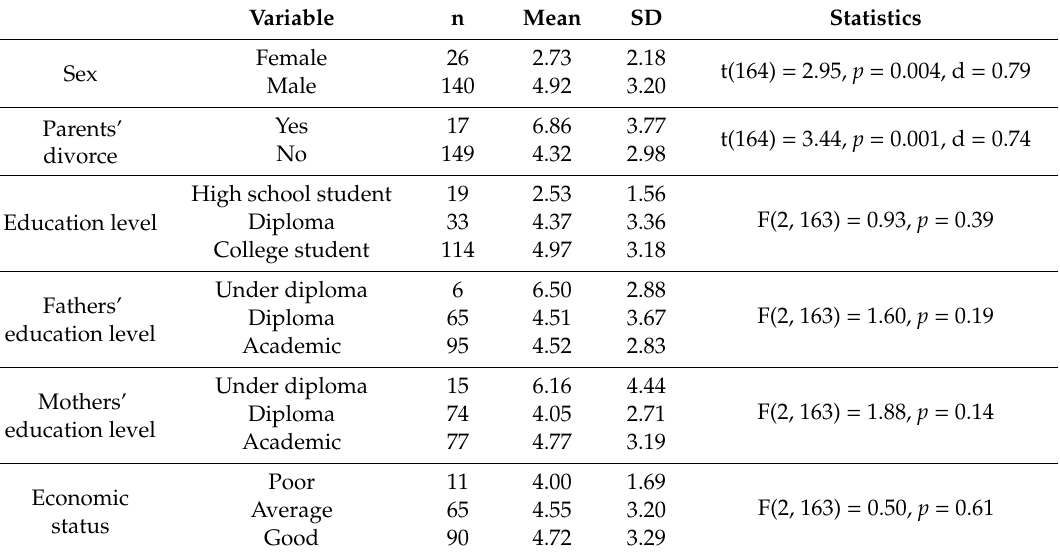
Table 3. Association between sociodemographic variables and weekly marijuana use.